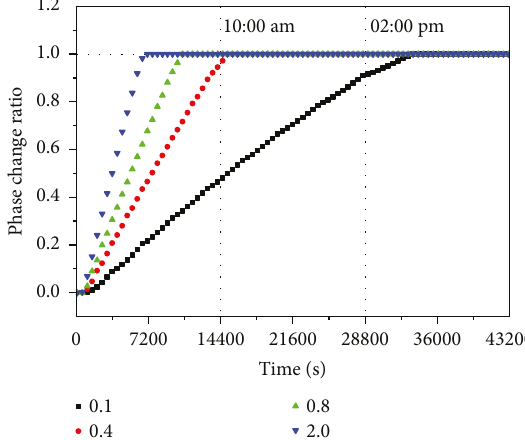
Figure 9: Phase change ratio of the PCM layer for case 2 under di ff erent thermal conductivities.